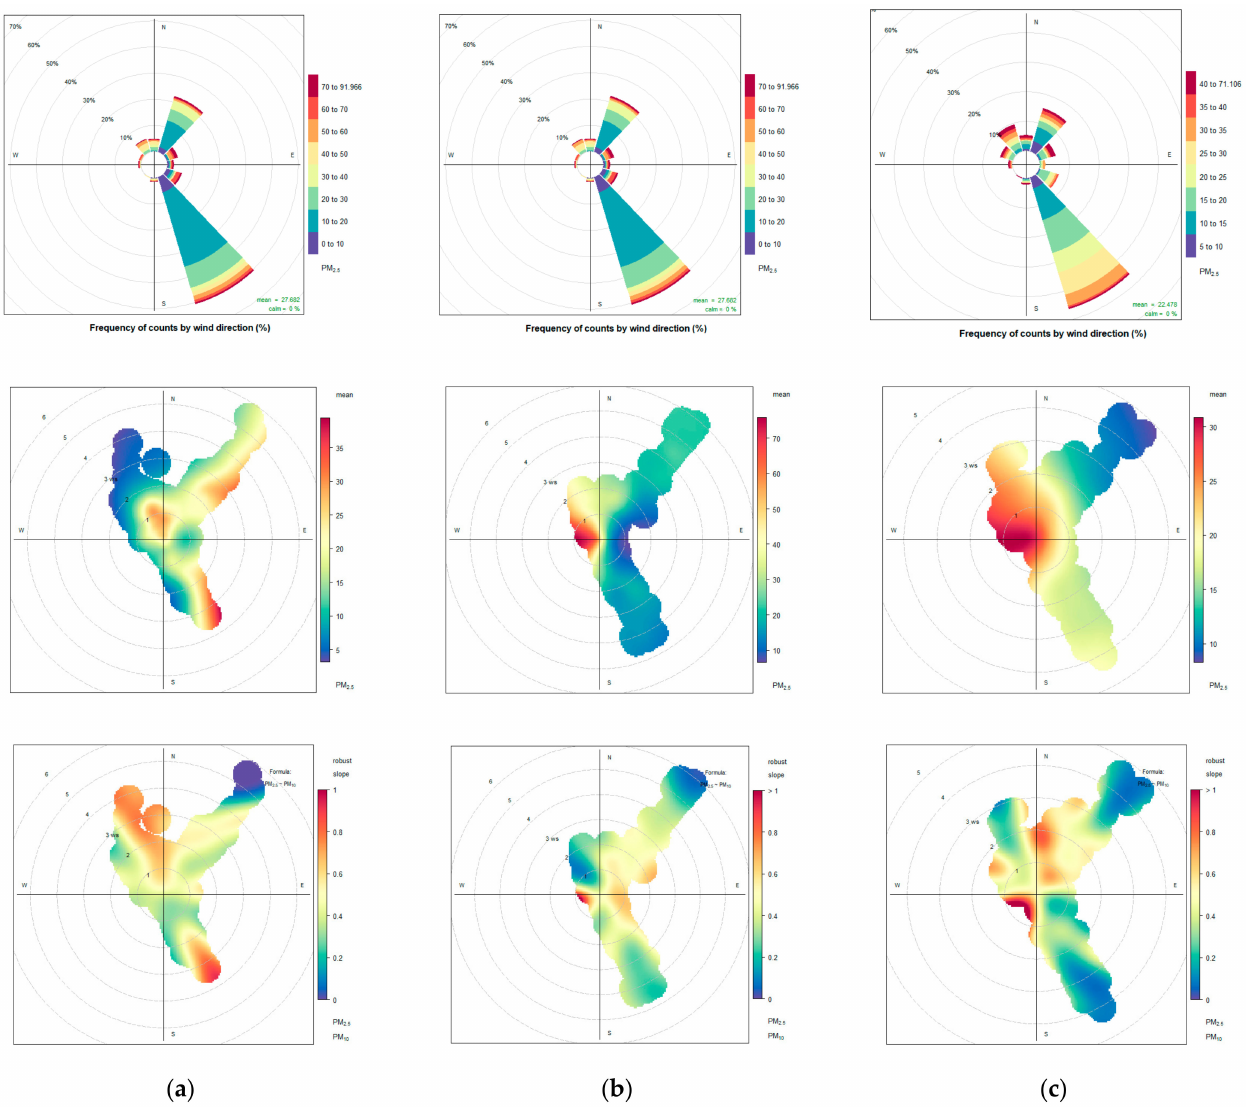
Figure 3. PM 2.5 [ µ g/m 3 ] counts by wind direction (upper row), PM 2.5 [ µ g/m 3 ] pollution rose (middle row) and PM 2.5 ~PM 10 robust slope (lower row) ( a ) before emergency state 1–15 March ( b ) during emergency state 16–31 March, Aralkum episode excluded ( c ) during emergency state 1–15